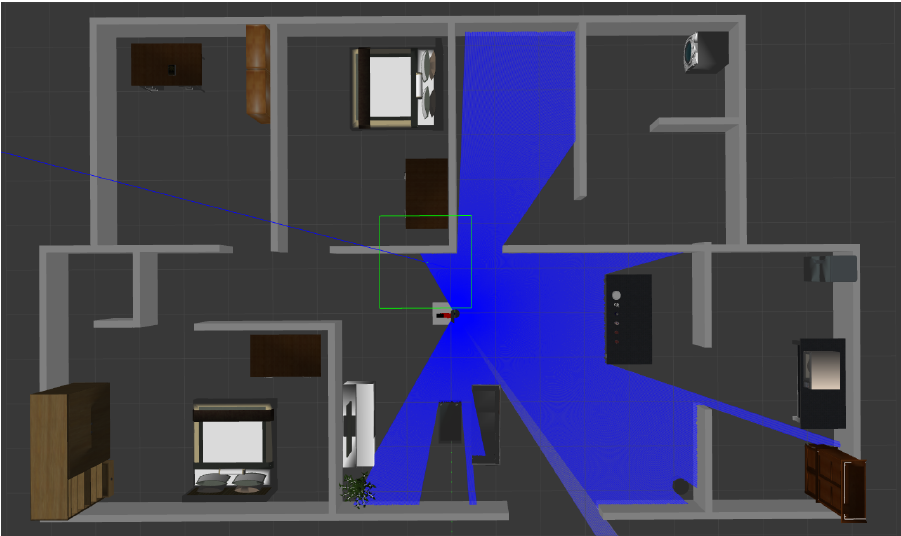
Figure 4. The domestic environment, which includes two bedrooms, one kitchen, one living room, and one